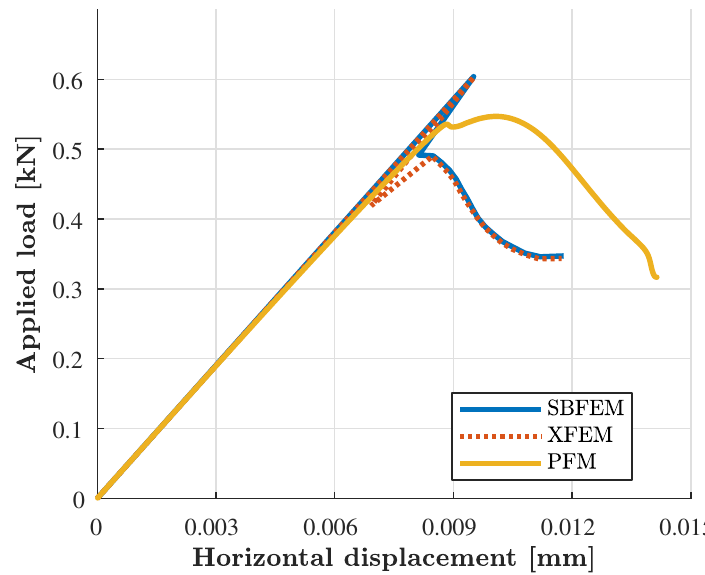
Figure 18. Load-deflection curves of the shear test.